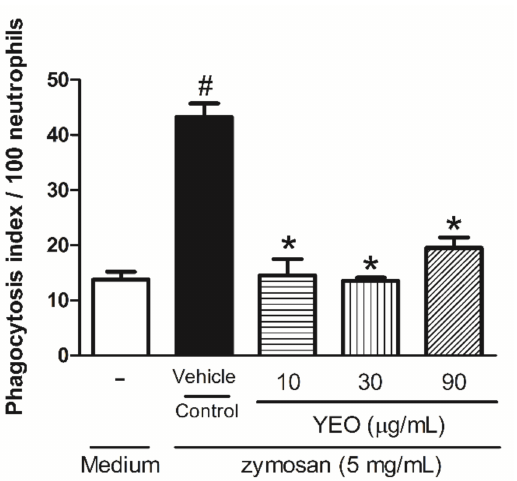
Figure 2. Effect of YEO on the phagocytic activity of neutrophils. Neutrophils were treated with different concentrations of YEO (10, 30, and 90 µ g/mL). The results are representative of three independent experiments. # p < 0.05 compared to medium, * p < 0.05, compared to the control group (ANOVA, Newman–Keuls